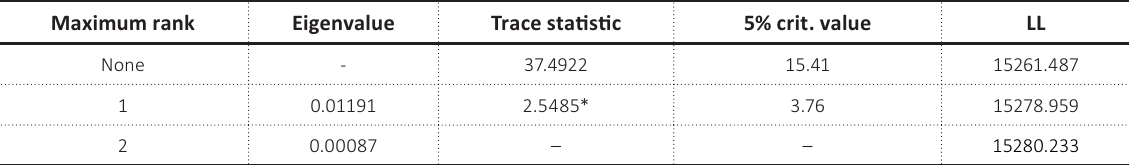
Note: This table reports the results obtained from Johansen cointegration test, performed in the second sub-period. The trace statistic has been computed using the eigenvalue in the line below it. * indicates that Johansen multiple-trace test procedure has been used to select the corresponding value of LL: